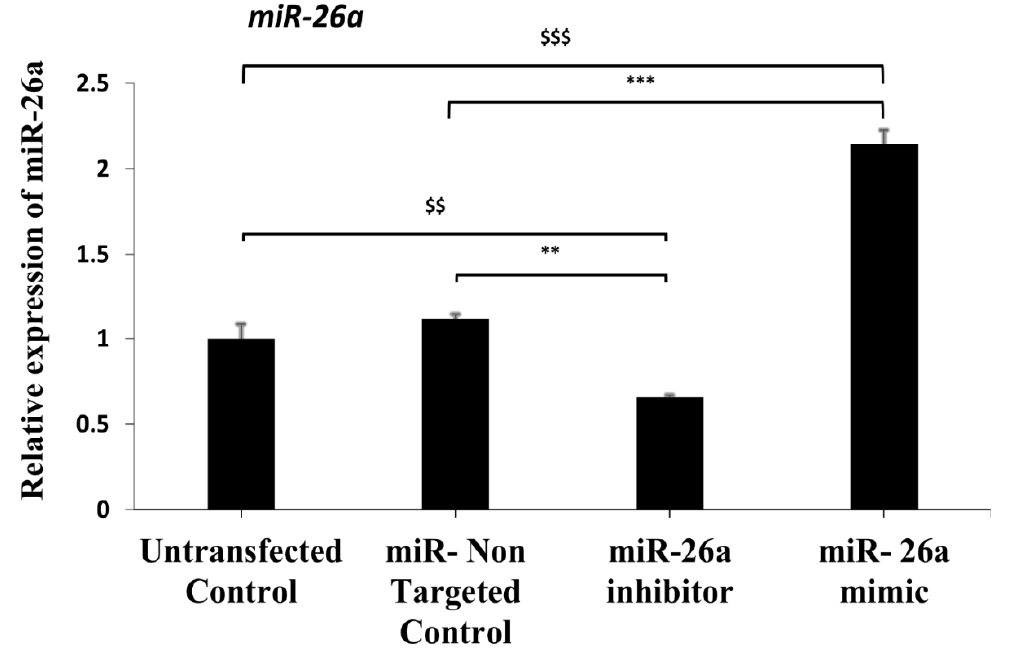
Figure 7. Utilization of the standardized technique for the electroporation and regulation of miR-26a. Expression of mmu-mir-26a in preantral follicles after transfection with miR-26a inhibitor and mimic. Preantral follicles were transfected with miR non-targeted control, miR-26a inhibitor and miR-26a mimic using 30 volts of 3 pulses at an interval of 10 s by electroporation. The expression of miR-26a was measured by qRT-PCR after 48 h of transfection and normalized by RNU6-6P expression. ** p < 0.01 and *** p < 0.001 indicate significant differences compared to the miR- non-target control group, whereas $$ p < 0.01 and $$$ p < 0.001 indicate significant differences compared to the untransfected control group.